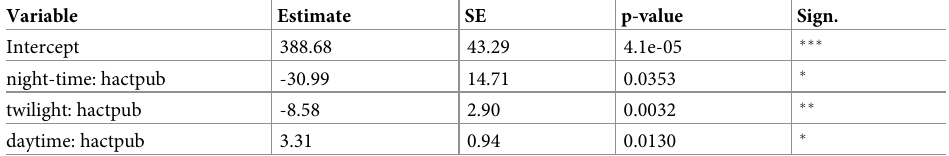
hactpub: hourly activity on public